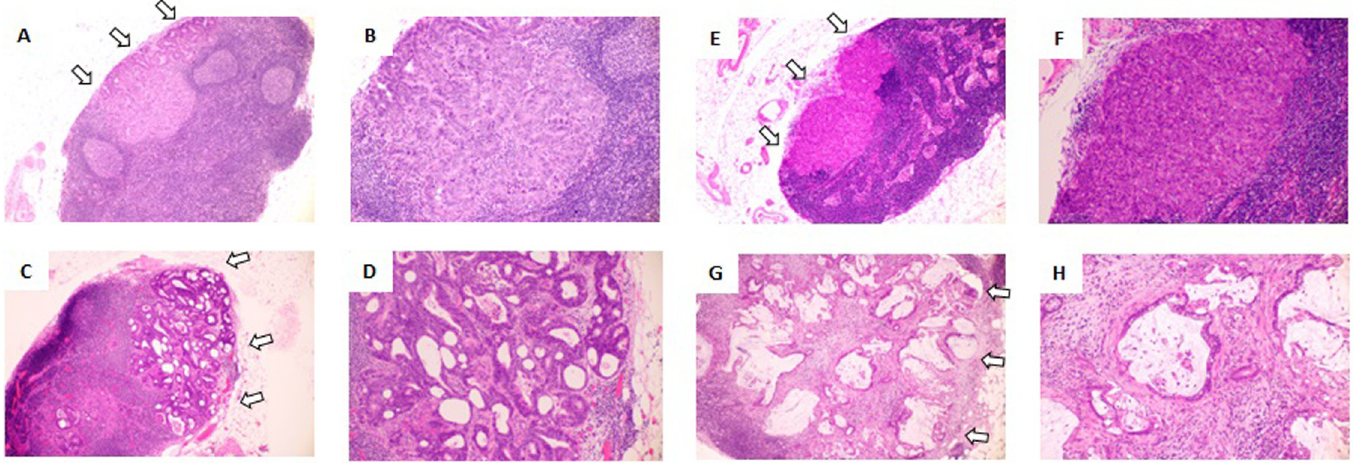
Fig 2. Homogeneous cancer histology presenting in a single metastatic lymph node. (A,B) Tubular adenocarcinoma. (C,D) Cribriform adenocarcinoma. (E,F) Poorly differentiated adenocarcinoma. (G,H) Mucinous adenocarcinoma. Original magnification: A, C, E, G: 40 × ; B, D, F, H: 100 × . Staining: Hematoxylin and eosin.